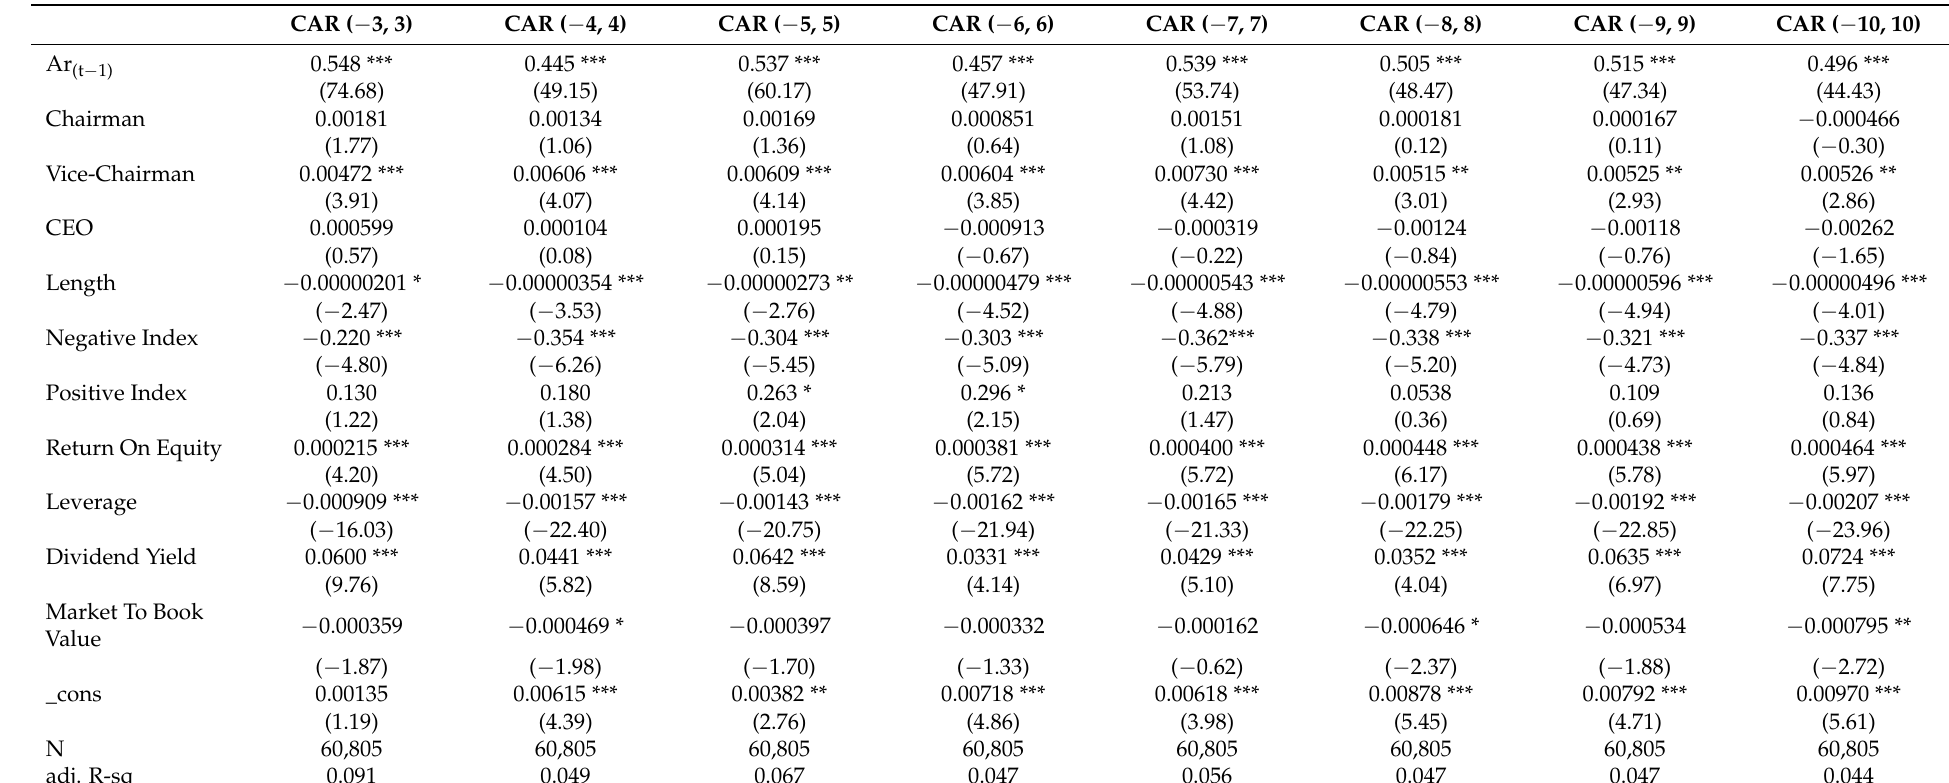
Table 9. Robustness tests. CEO duality, sentiment and stock market reaction, over longer